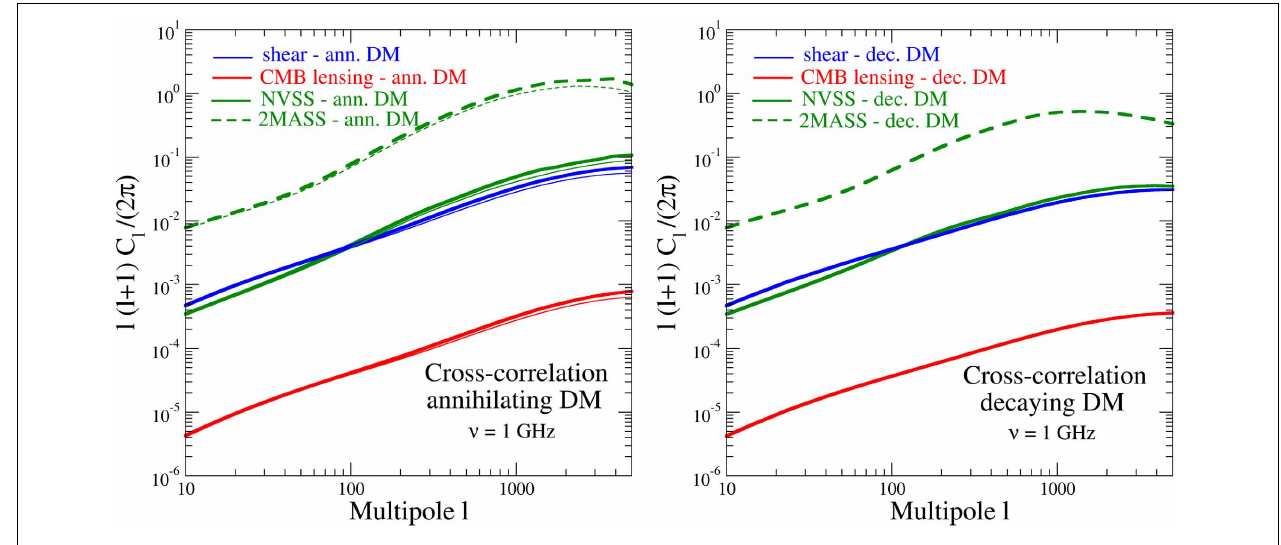
FIGURE 6 | Angular cross-correlation PS between the radio signals (at ν = 1 GHz) and gravitational tracers (cosmic shear, CMB lensing and LSS tracers), for annihilating DM (left panel) and decaying DM (right panel). The computation is performed using the